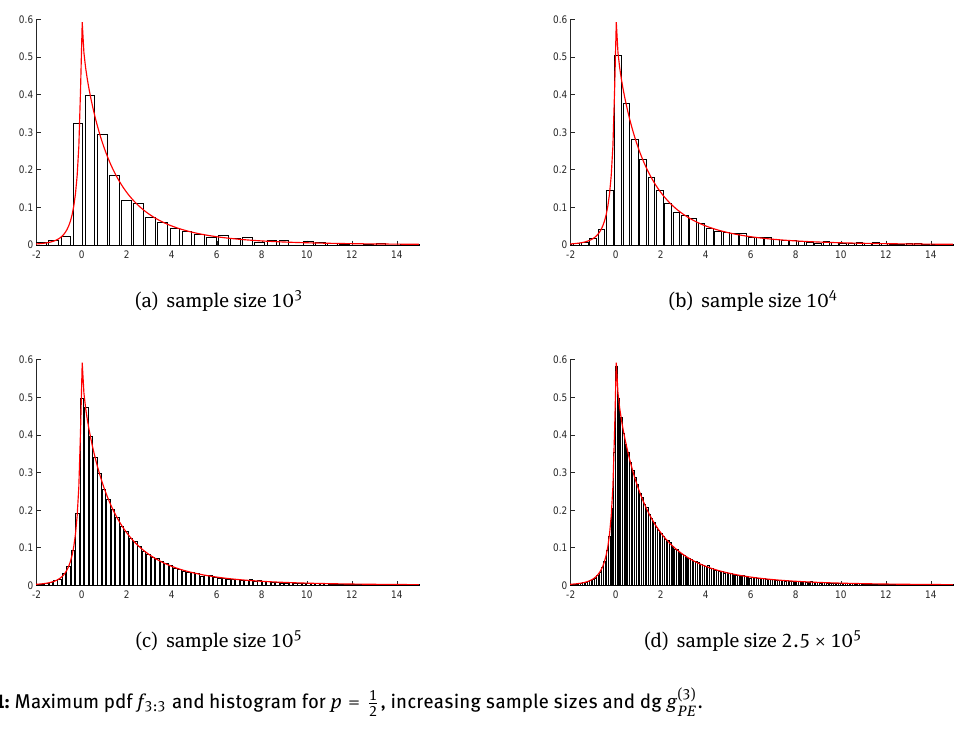
Figure 1: Maximum pdf f 3:3 and histogram for p = 1 2 , increasing sample sizes and dg g (3)